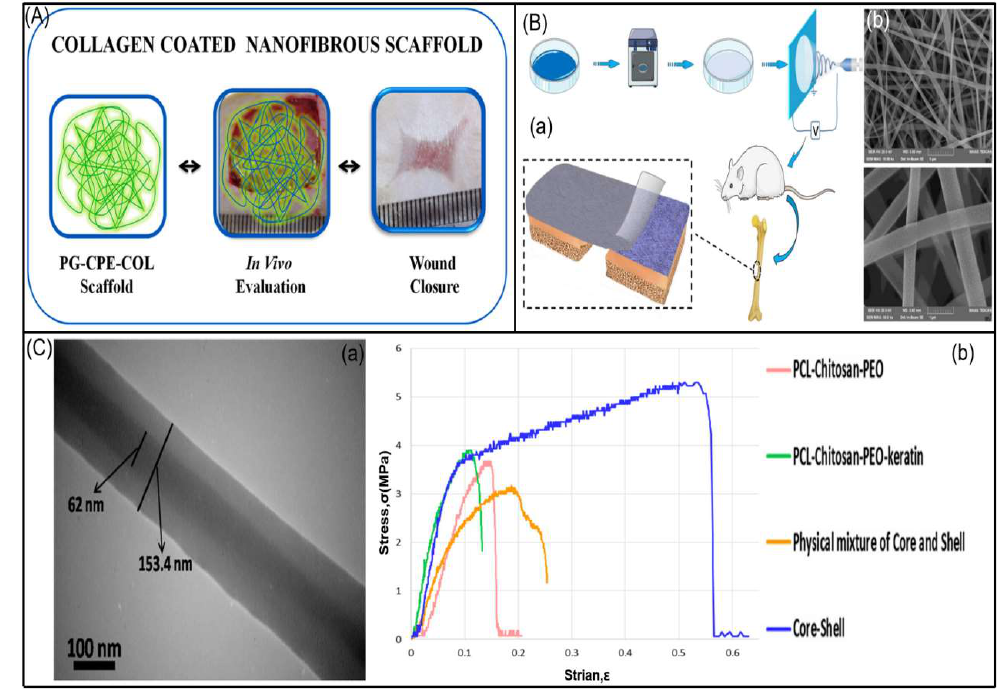
Figure 9. Protein polymer-loaded herbal medicine nanofibers. ( A ) PG-CPE-COL nanofiber scaffold, reprinted with permission from [228] copyright 2017, Elsevier. ( B ) ( a ) Schematic diagram of prepa- ration and implantation method of BER @ PCL/PVP-MC/CS bilayer membrane; ( b ) Diameter distri- bution under SEM images, reprinted with permission from [229] copyright 2021, Frontiers in Bioen-